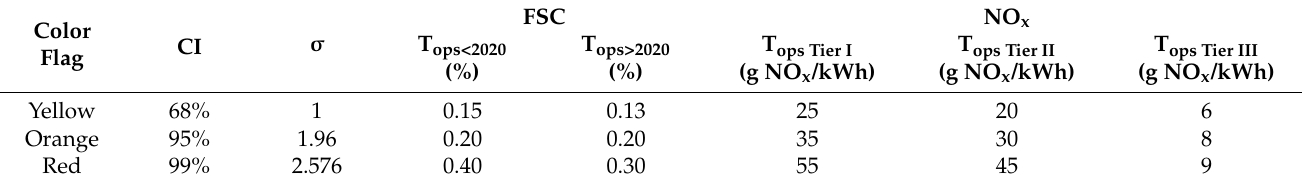
Table 1. Applied thresholds for FSC and NO x compliance monitoring.